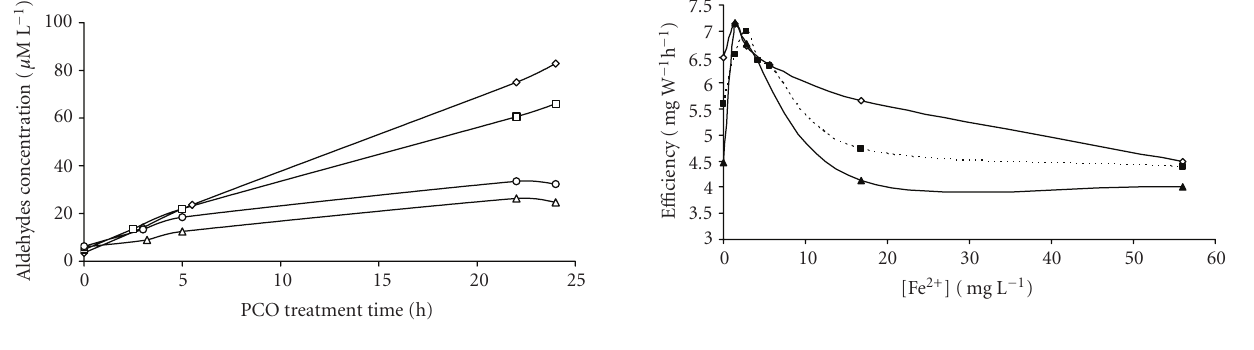
Figure 5: The increase of aldehydes concentration in PCO treat- ment time at di ff erent pH: pH 3 ( (cid:4) ), pH 7 ( (cid:3) ), pH 9 ( (cid:6) ), pH 11 ( ◦ ); initial concentration of lignin 100mg L − 1 ; plate 0.75 mg cm − 2 (spraying).